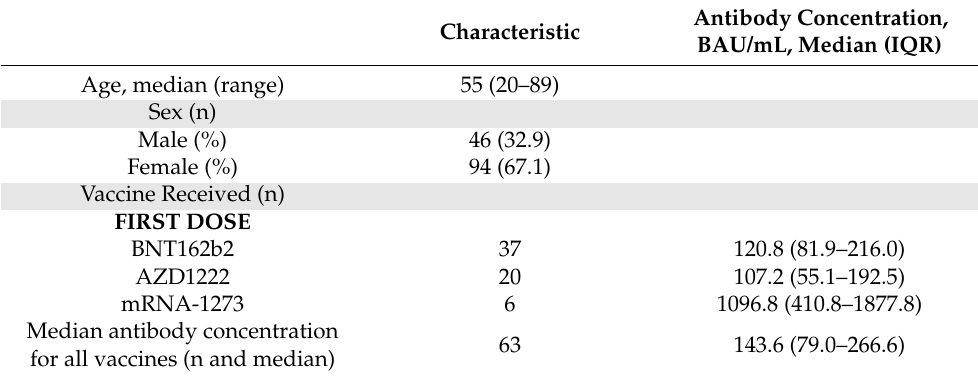
Table 1. Characteristics of 140 Healthy Study